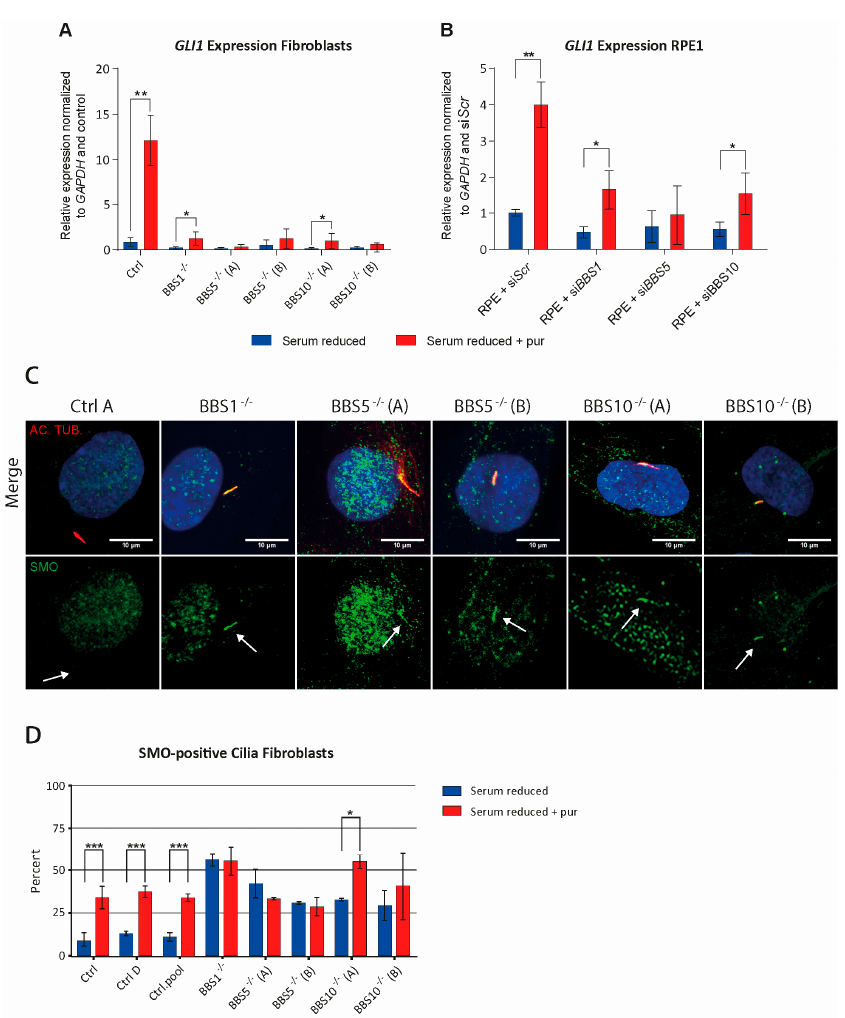
Figure 2. Investigation of Hedgehog (Hh) signaling in control and BBS-defective cells. ( A ) Investiga- tion of Hh signaling fibroblast. Expression profile of GLI1 mRNA was normalized to the amount of endogenous GADPH mRNA. Pur-induced expression of GLI1 was significantly increased in control cells compared to patient fibroblasts (BBS1 − / − : * p = 0.015711, BBS5A − / − : * p = 0.012758, BBS5B − / − : * p = 0.014811, BBS10A − / − : * p = 0.014944, BBS10B − / − : * p = 0.013701). Compared to unstimulated